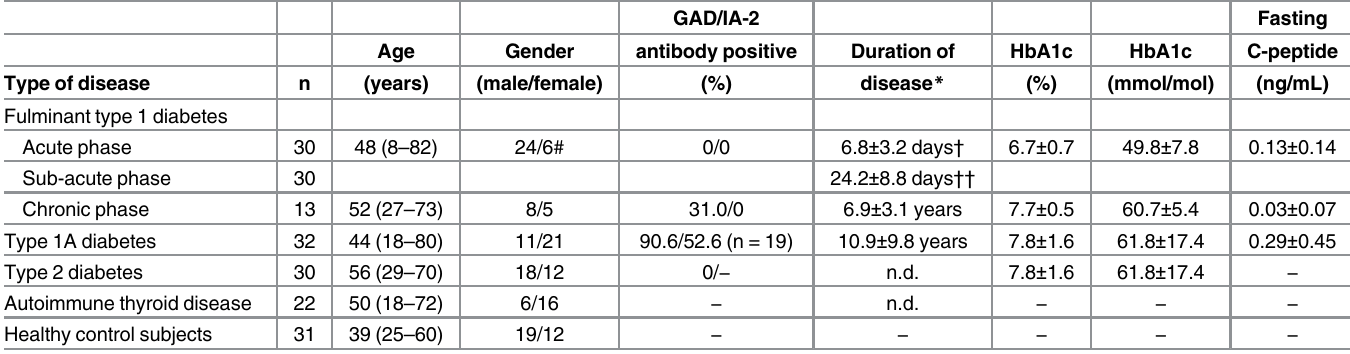
Table 2. Clinical characteristics of the